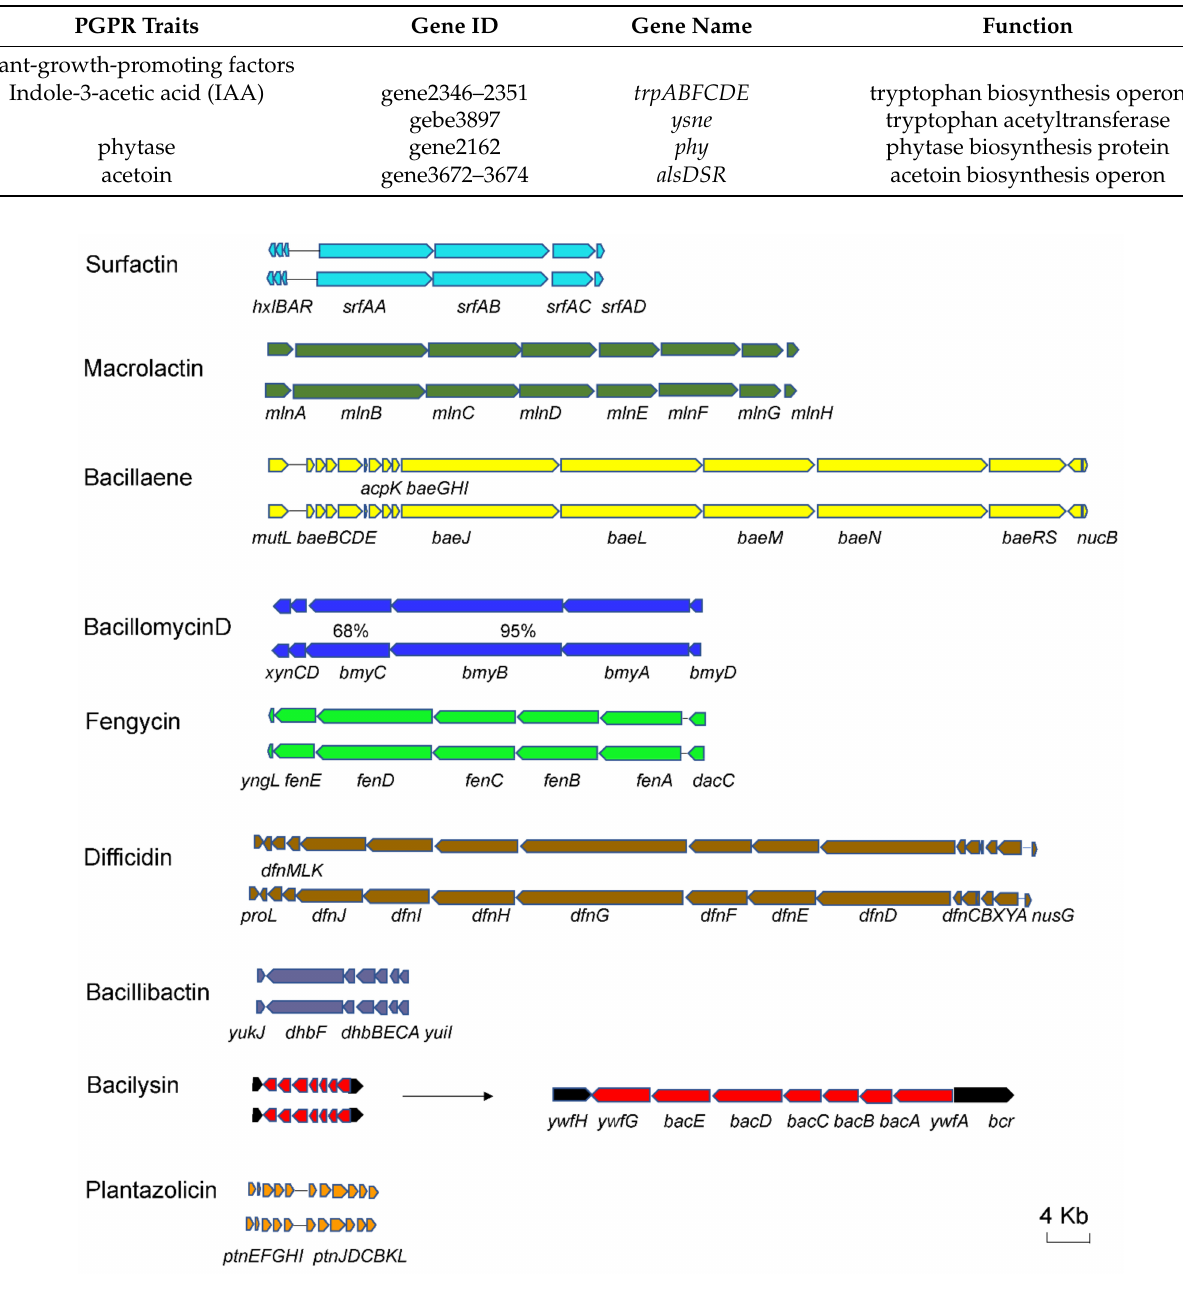
Figure 4. Comparisons of NRPS, TransATPKS, and lantipeptide clusters in SC60 (above) and FZB42 (below). The percentage indicates less than 98% identity between strain